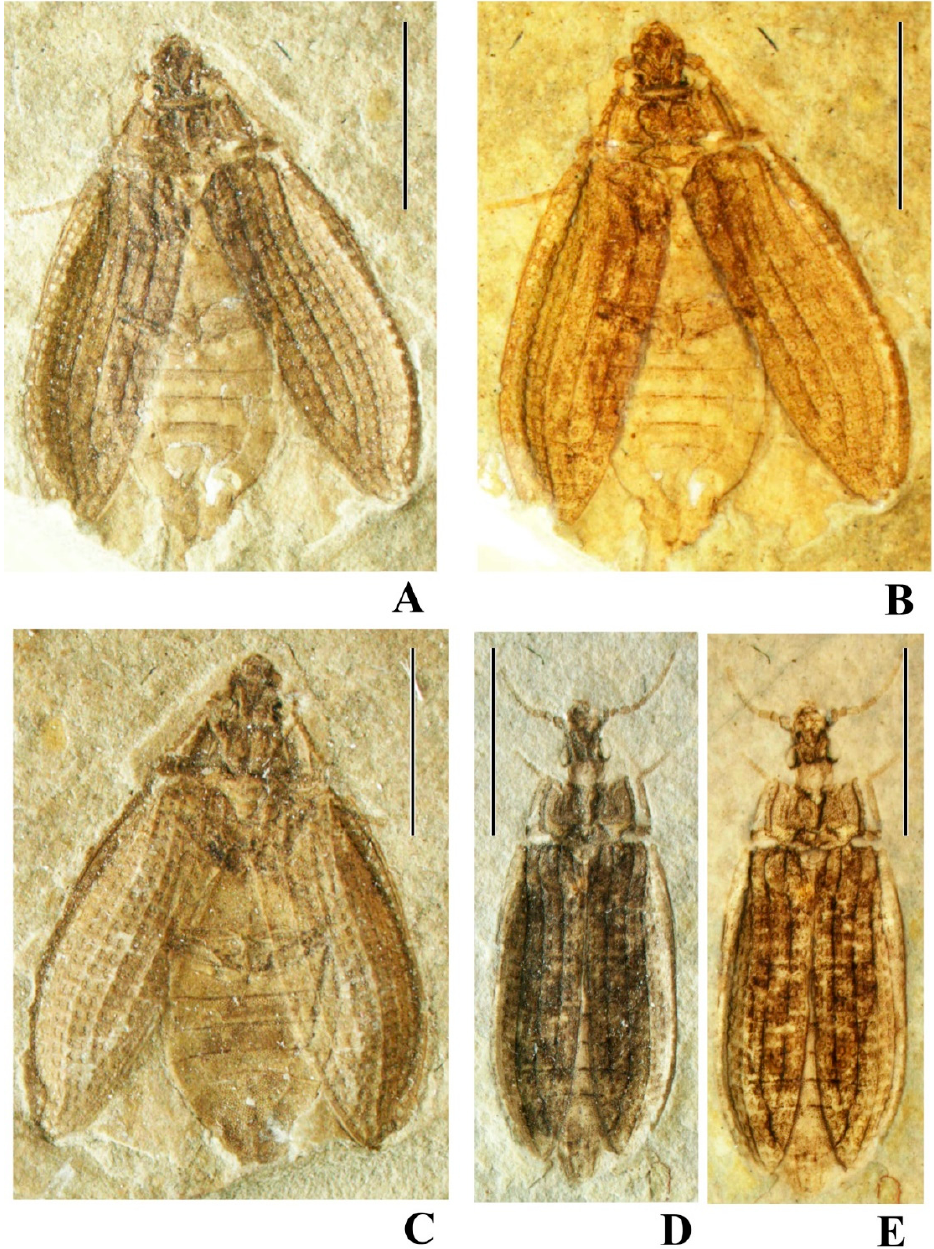
Figure 19. Ommatinae (Cupedidae): A–C— Zygadenia porrecta comb. nov. [ Amblomma, Notocupes ], holotype, CNU-C-LBC2005006-1, part and CNU-C-LBC2005006-2, counterpart (Lower Cretaceous, Lower Aptian; Liaoning, Chaomidian): A —part, dry; B —same, wettened by alcohol; C —counterpart, dry; length of print 12.0 mm, scale bar = 4.3 mm; original. D-E— Zygadenia protensa comb. nov.